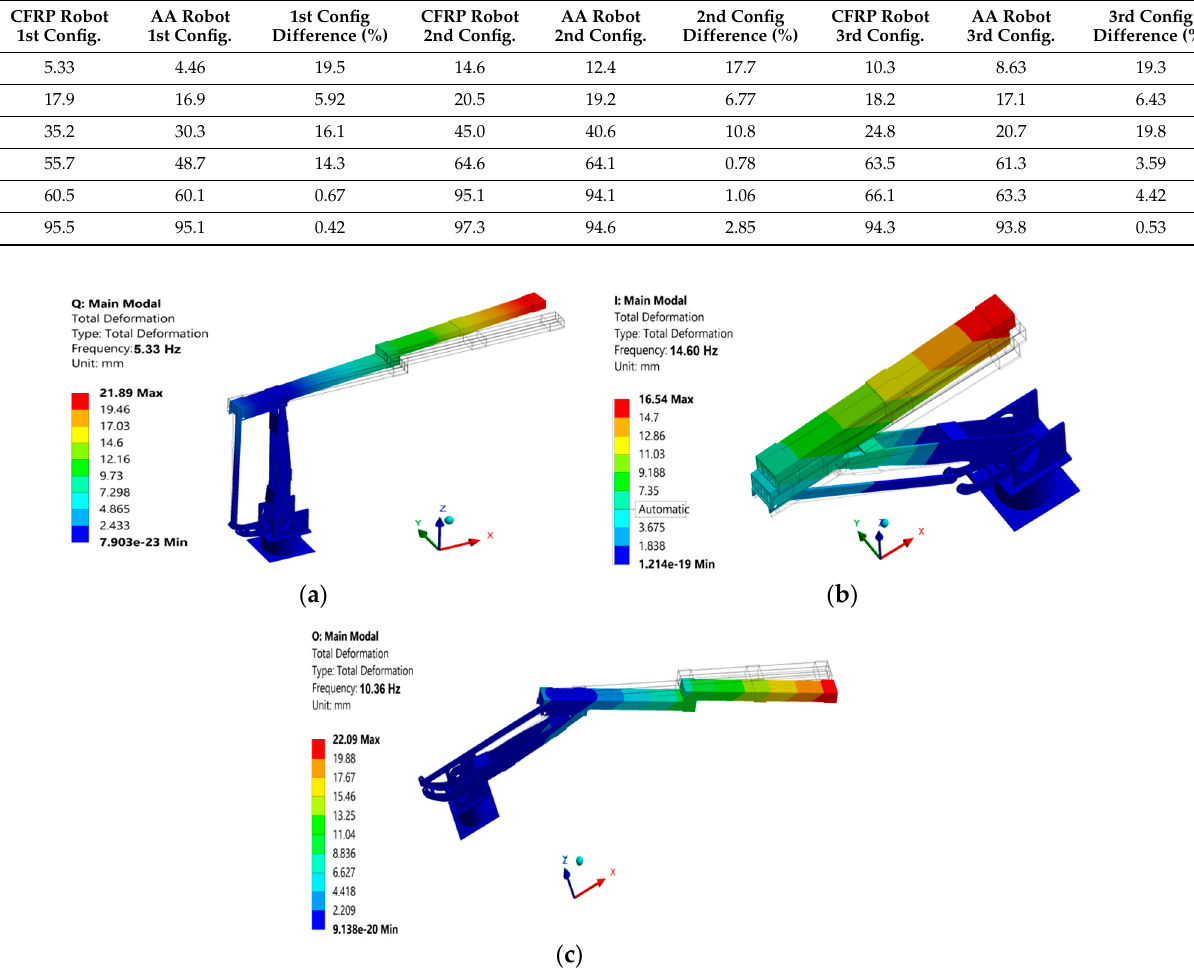
Figure 9. First mode shapes of the CFRP manipulator: ( a ) first configuration, ( b ) second configuration, and ( c ) third configuration.